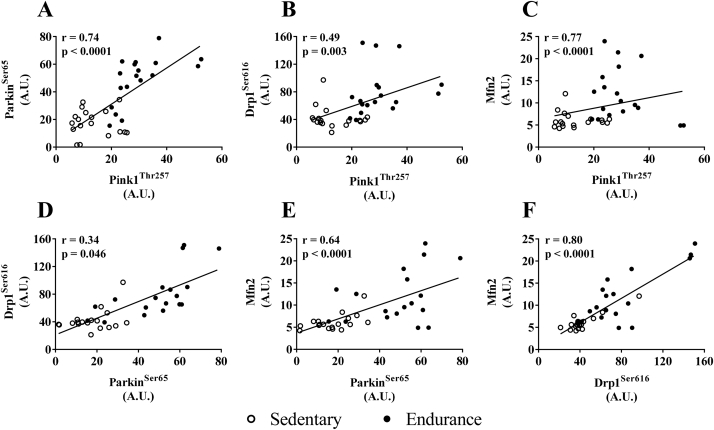
Correlations between skeletal muscle content of mitophagy and mitochondrial dynamic proteins. (A&B) phospho-Pink1Thr257 and phospho-ParkinSer65, (C&D) phospho-Pink1Thr257 and phospho-Drp1Ser616, (E&F) phospho-Pink1Thr257 and Mfn2, (G&H) phospho-Drp1Ser616 and Mfn2. Correlations were based on fasted and post-HFM data points.